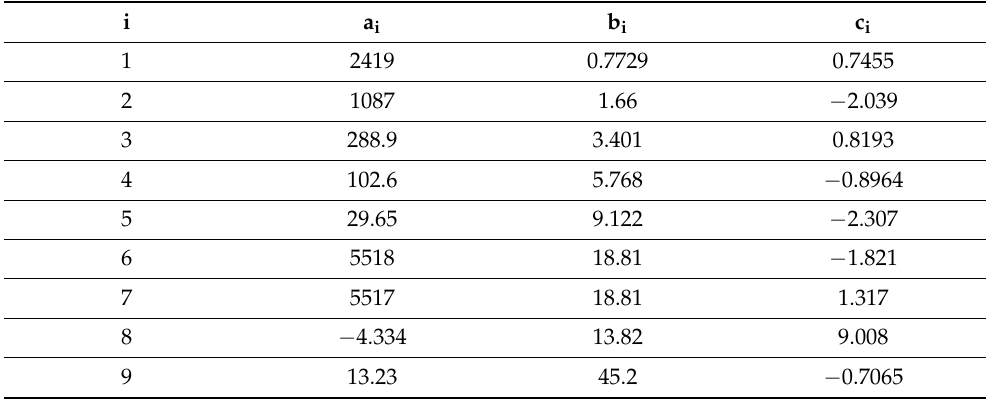
Table 1. Coefficients of sum-of-sines fitting function.